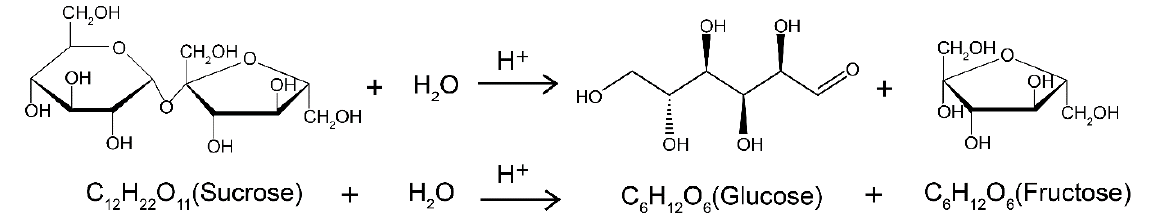
Figure 3. The chemical formula of sucrose hydrolysis.